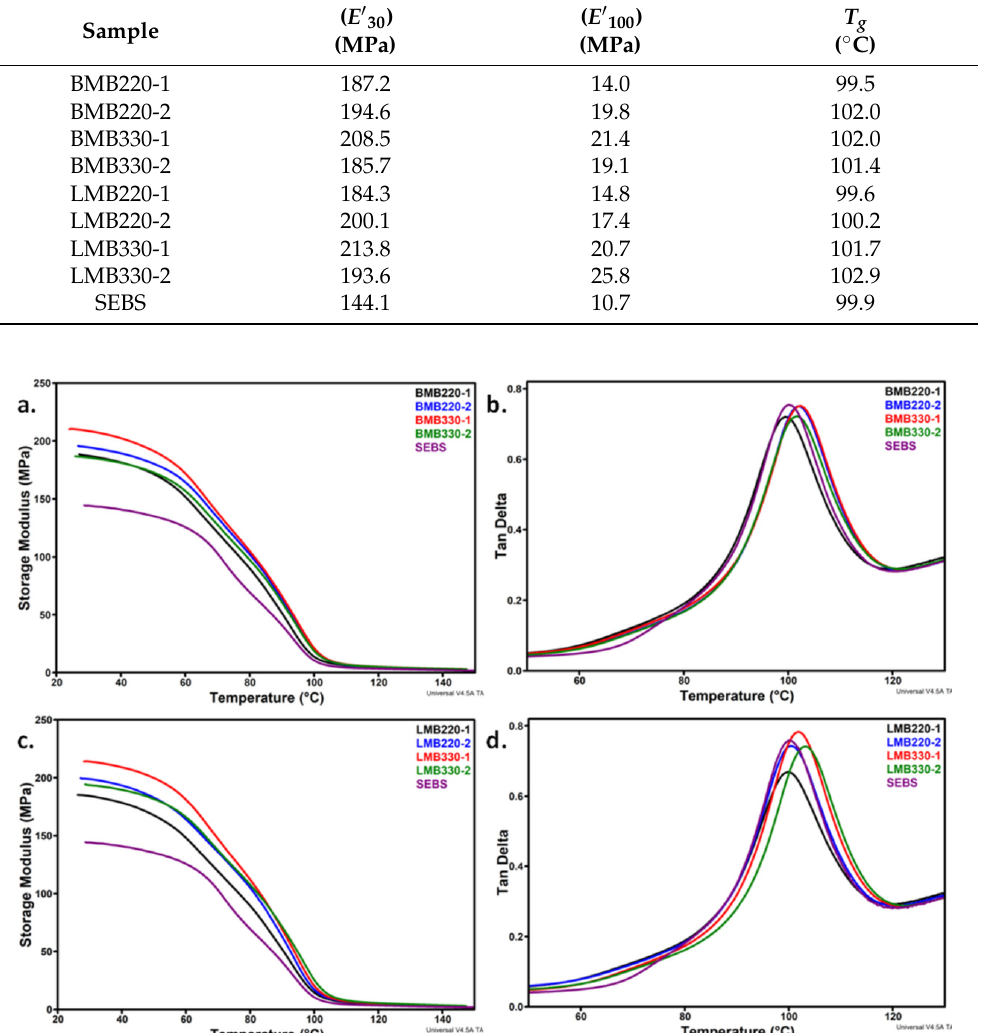
Table 3. Storage modulus at 30 ◦ C ( E (cid:48) 30 ) and at 100 ◦ C ( E (cid:48) 100 ) and the glass transition temperature ( T g ) for SEBS and masterbatches.